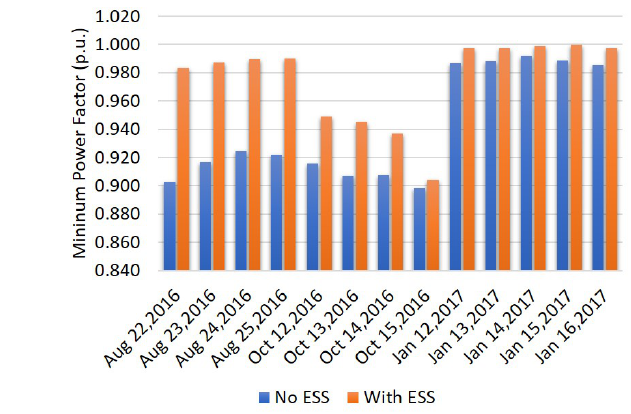
( b ) Mininum power factor correction for all testing days Figure 6. Power factor correction